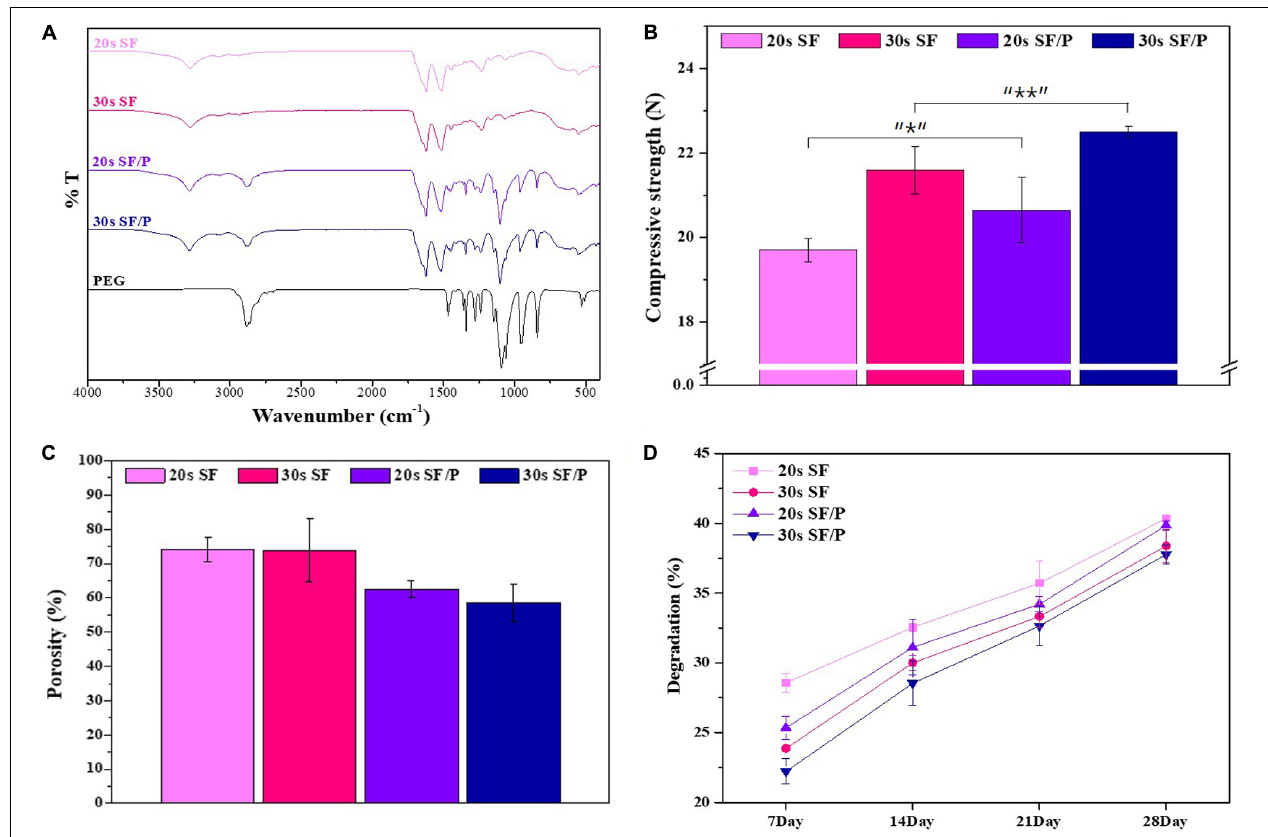
FIGURE 2 | (A) FT-IR spectra of SF, SF/P hydrogels, and PEG powder. Graphs showing (B) compressive strength, (C) porosity, and (D) degradation test of 20s SF, 30s SF, 20s SF/P, and 30s SF/P hydrogels ( n = 3; * p < 0.5, ** p < 0.05, and *** p <